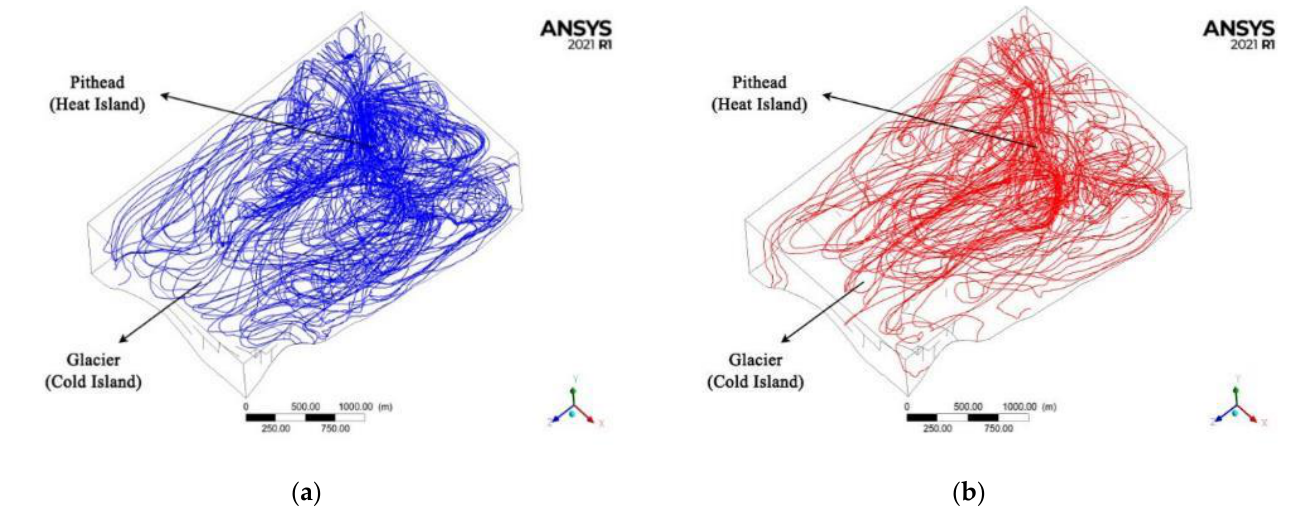
Figure 9. Dust diffusion paths in ( a ) winter and ( b ) summer. As shown in Figure 10, the particle-tracking function of the FLUENT software can be applied to derive the position and particle size of the dust particles captured on the glacier surface. It can be observed that larger distances between the glacier and the mine correspond to a narrow particle size distribution of dust settling on the glacier surface. The proportion of the larger particles decreases with increasing distance, while the proportion of the smaller particles increases with increasing distance. More dust particles, especially larger ones, spread to the glacier surface in winter due to greater temperature differences and wind speeds than in summer. For example, the particles with a 0.16 mm diameter account for the largest proportion of dust particles at a distance of 1.4 km in winter, while the particles with a 0.16 mm diameter rarely reach the glacier’s surface in summer.